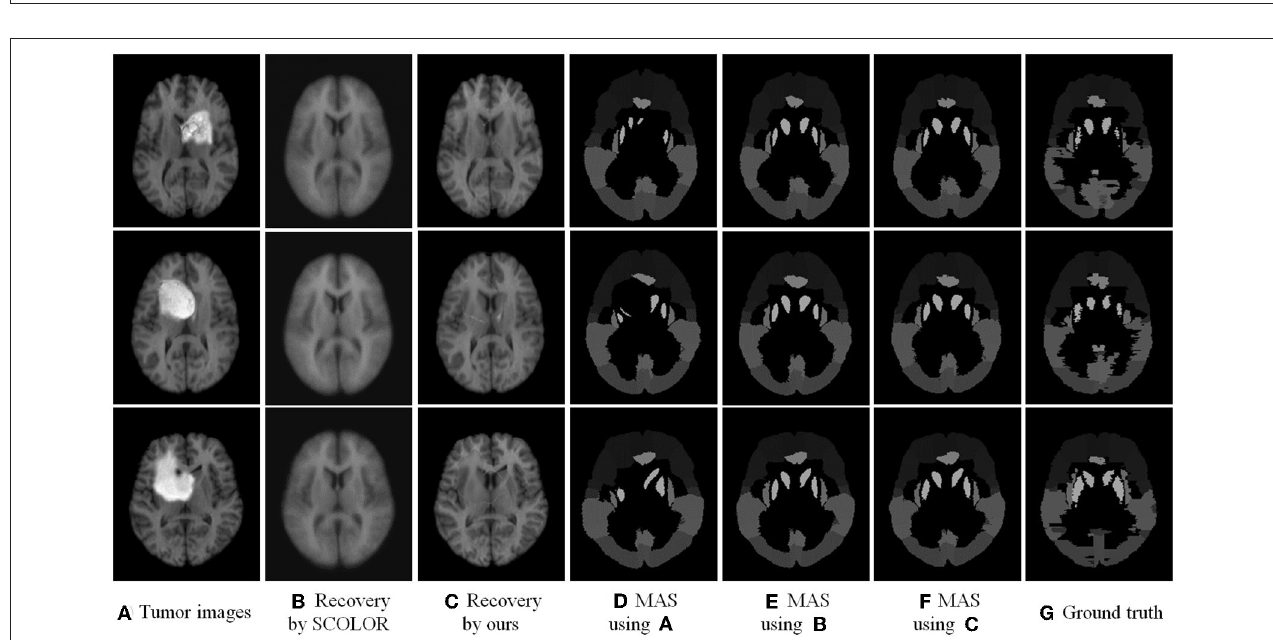
FIGURE 7 | The illustration of the multi-atlas segmentation framework.